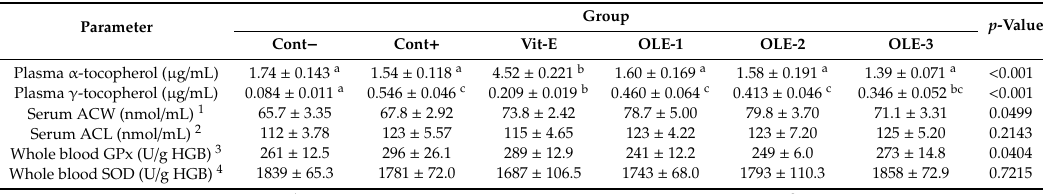
Nomenclature as in Table 1. 1 Antioxidant capacity of water-soluble antioxidants. 2 Antioxidant capacity of lipid-soluble antioxidants. 3 Glutathione peroxidase. 4 Superoxide dismutase. Values within the same row with di ff erent superscripts di ff er significantly ( p < 0.05).